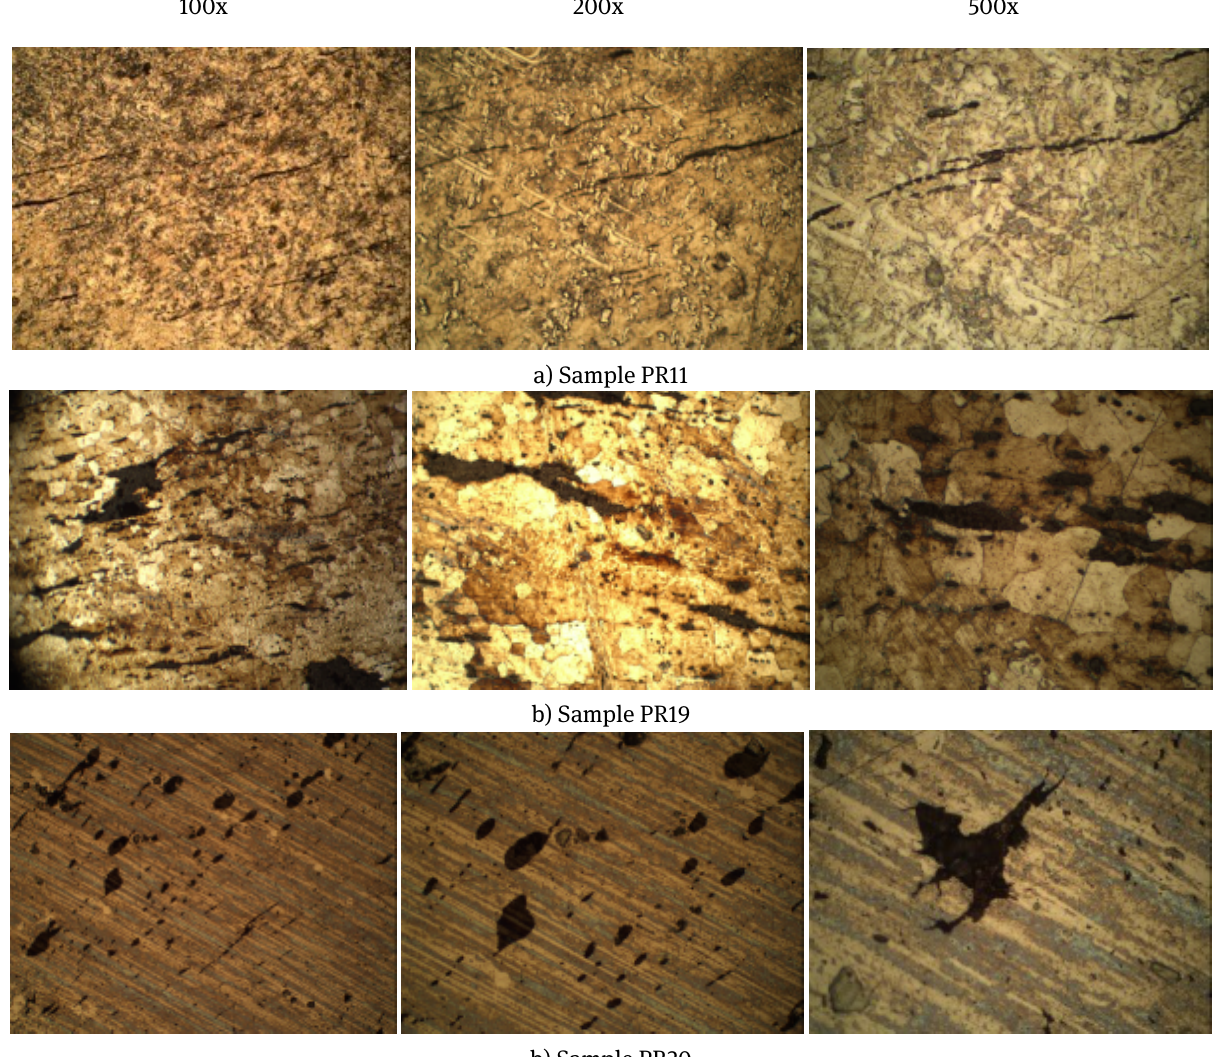
Figure 7: Surface microstructure images of nail samples.